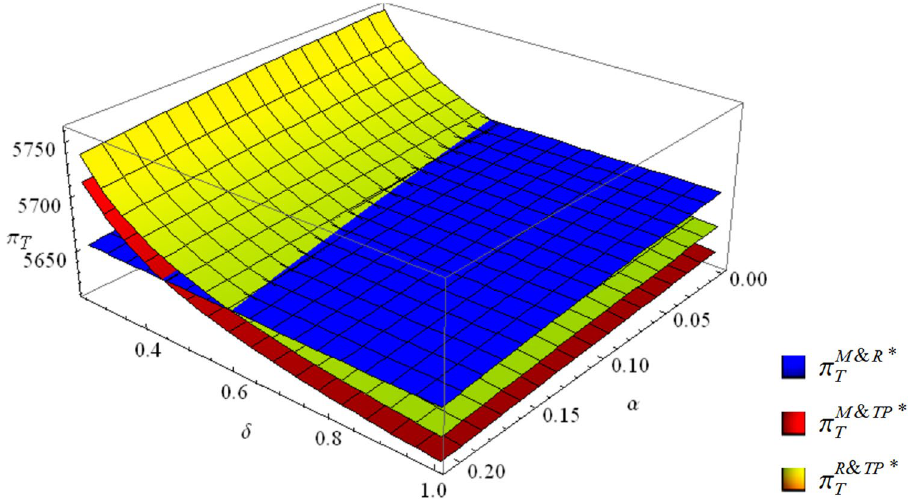
Figure 4. The total profits of the three collection modes.